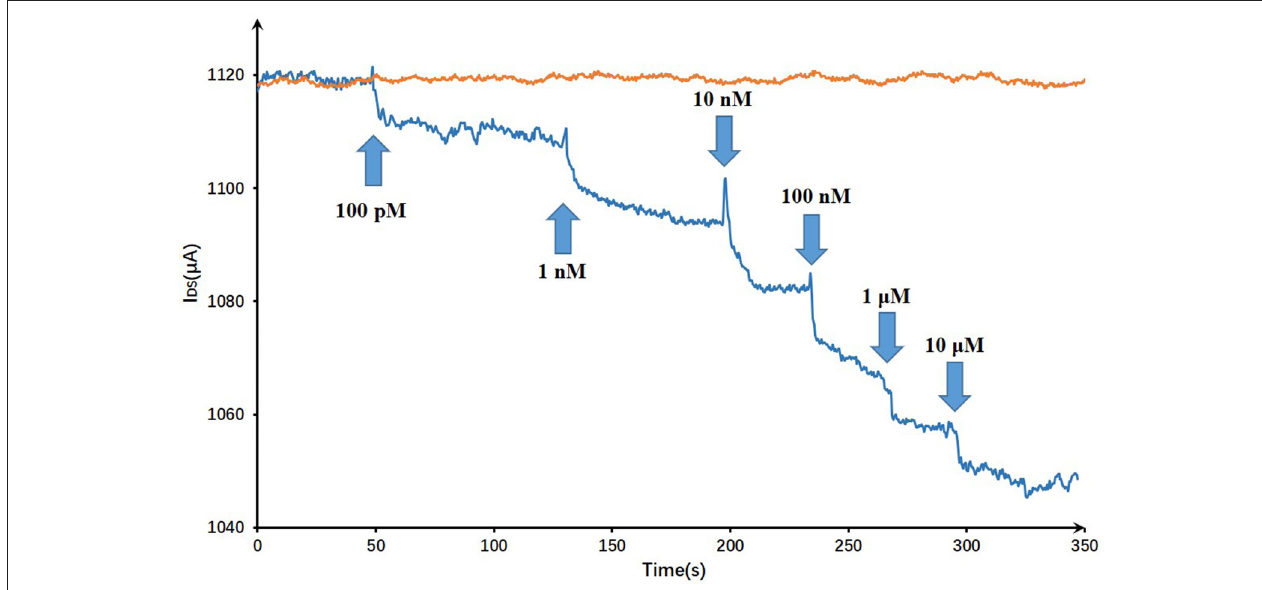
FIGURE 7 | Dynamic responses of the DNA-based biosensor to Hg 2 + and a blank control: the arrows pointed the adding time and corresponding concentrations.